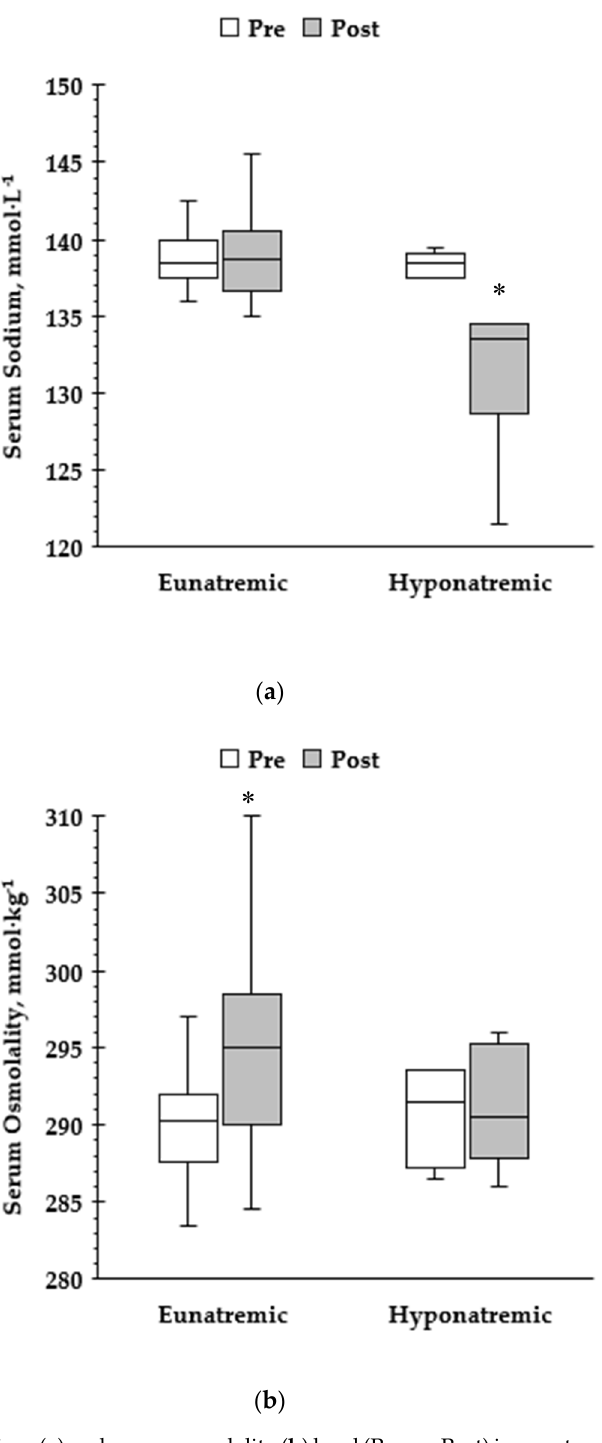
Figure 1. Serum sodium ( a ) and serum osmolality ( b ) level (Pre vs. Post) in eunatremic vs. hyponatremic runners. * Denotes statistically significant difference from baseline value.